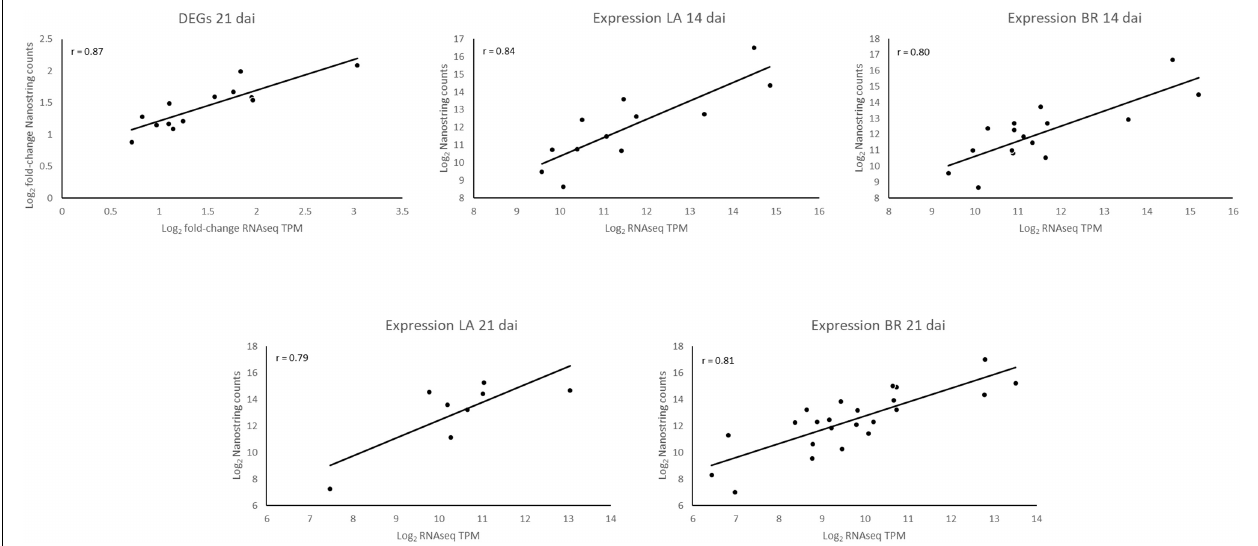
FIGURE 6 | Validation of RNAseq data using nCounter Nanostrings technology. We evaluated 28 target genes which were either differentially expressed 21 dai or consistently expressed in both cultivars at 14 and 21 dai. As seen from the graphs, not all scatter plots have the same number of points, which reflects different amounts of genes evaluated under the different analyses according to the obtained results. (LA) P. brassicae genes coming from the interaction with ‘Laurentian,’ (BR) P. brassicae genes coming from the interaction with ‘Brutor,’ (DEGs) Differentially Expressed